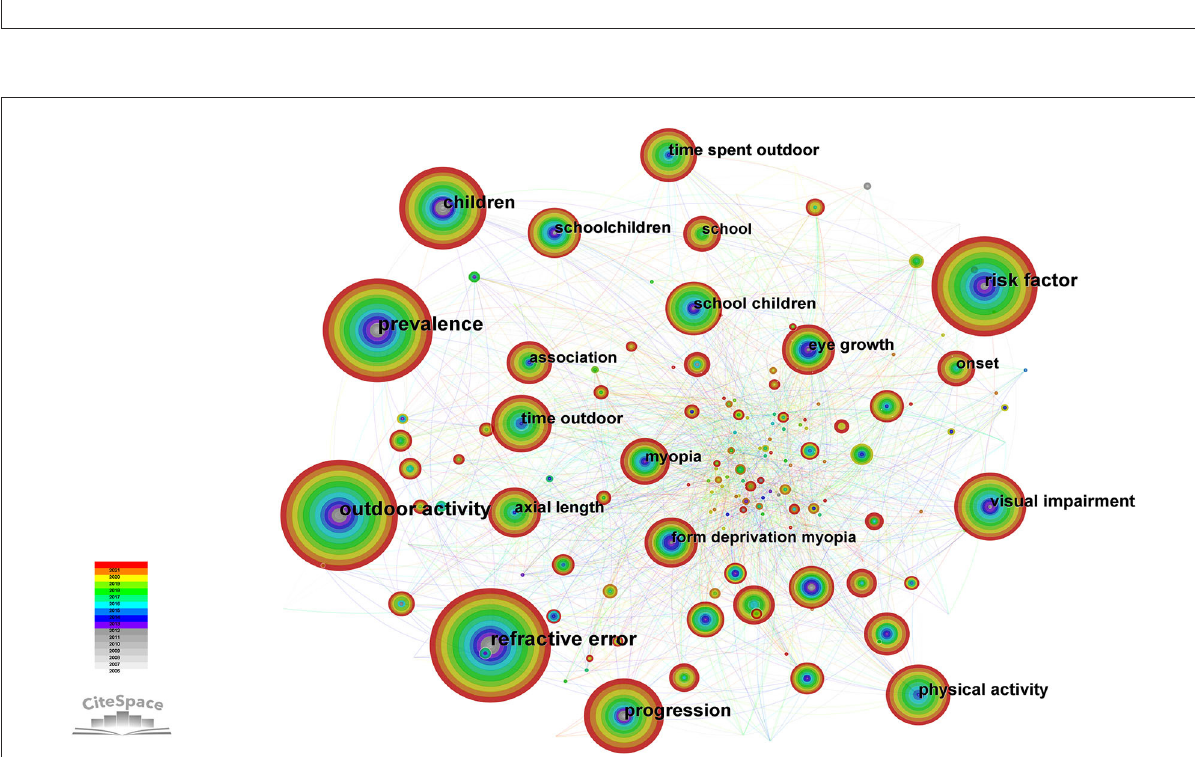
FIGURE7 Keywords of studies on the relationship between outdoor activities and myopia from 2006 to